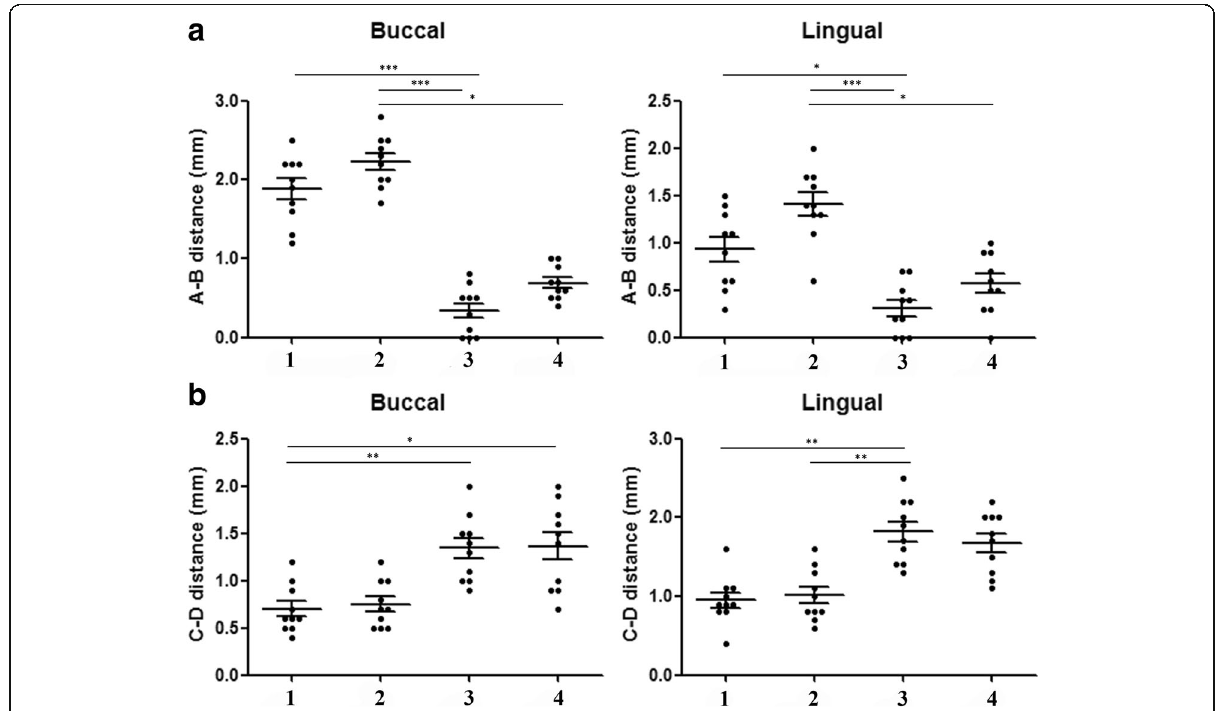
Fig. 7 Multiple graphs comparing A-B distance (height bone) ( a ) and the C-D distance (tissue thickness) ( b ) among different groups. Differences between groups were assessed by Dunn ’ s multiple comparison test (* P <0.05; ** P <0.01; *** P <0.001). 1 = (group 1) implant installed in fresh extraction and submerged; 2 = (group 2) implants in fresh extraction and immediately exposed; 3 = (group 3) implants installed in healed site and submerged; and 4 = (group 4) implants in healed site and immediately